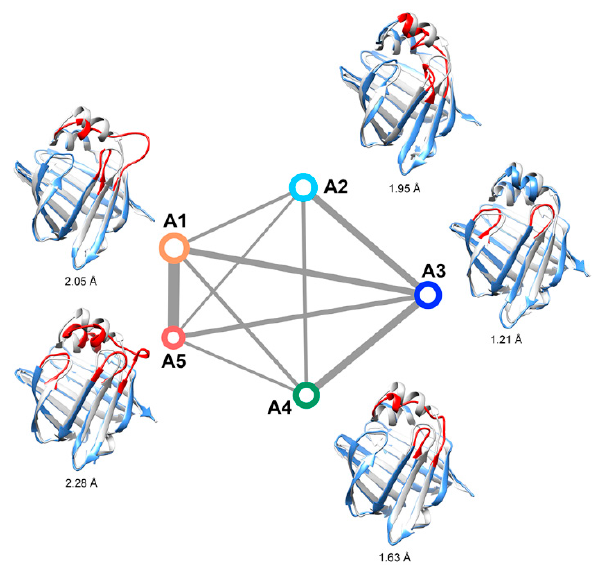
Figure 3. Kinetic network of the intermediates of apo-FABP. The size of each node is proportional to the population of the corresponding intermediate state. The width of each edge is proportional to the apparent free energy barrier between the two nodes. The root-mean-square deviations (RMSDs) between the representative structure (yellow) of the states and the crystal structure (gray) are given, and the regions with large structural di ff erences are shown in red.